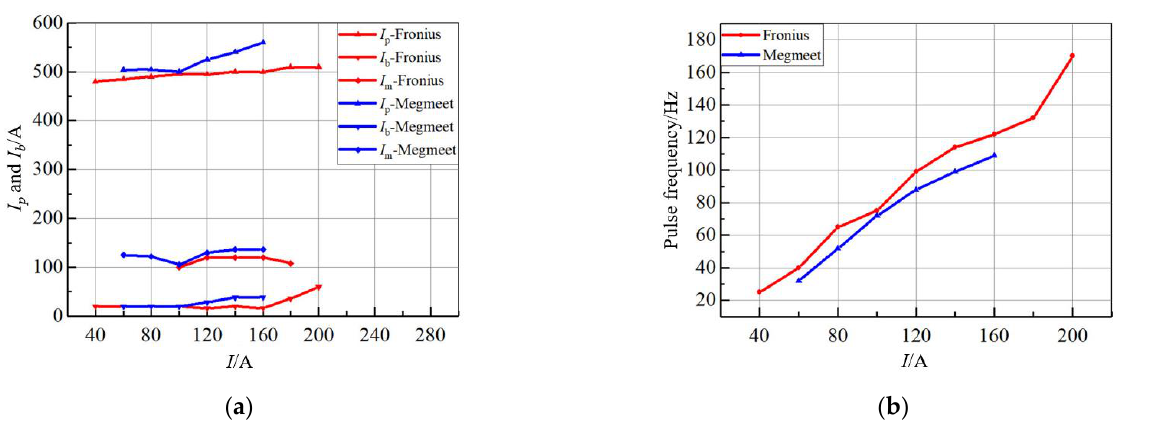
Figure 3. The pulse waveform parameters with different currents supplied by a Fronius TPS5000 and Megmeet PM500A: ( a ) parameters of the waveform; ( b ) frequency of the pulse. Table 1. The welding parameters used in this article.